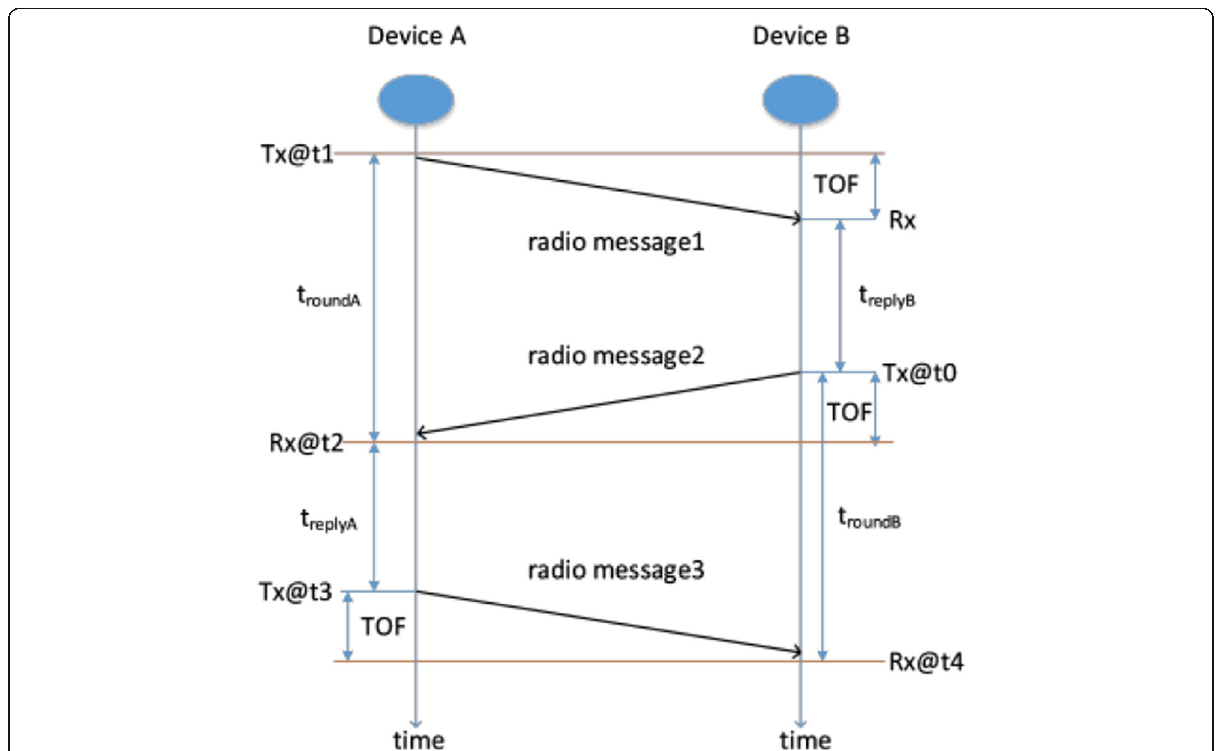
Fig. 4 Two-way ranging process. Device A and device B are two DWM1000 modules. Device A initiates ranging requests while device B listens and respond the radio message from device